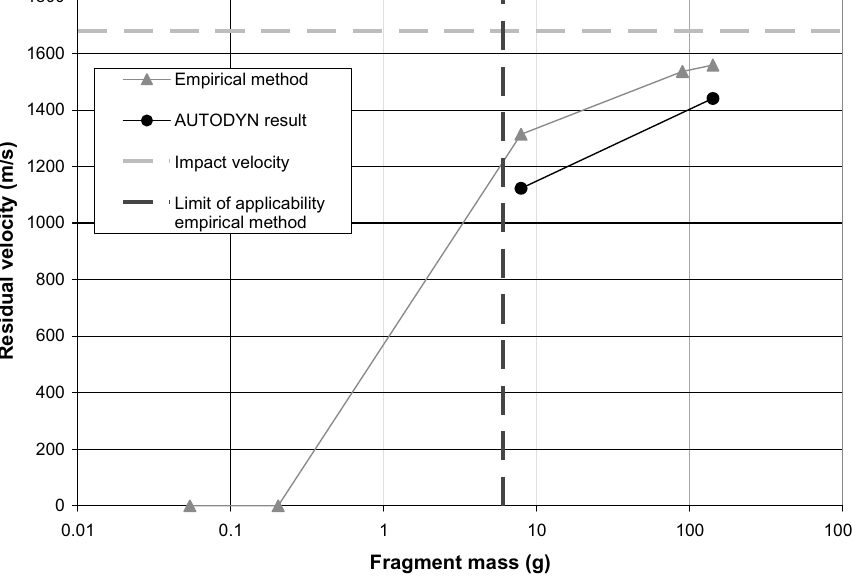
Fig. 5. Comparison of AUTODYN results against empirical methodology for 4000 psi concrete